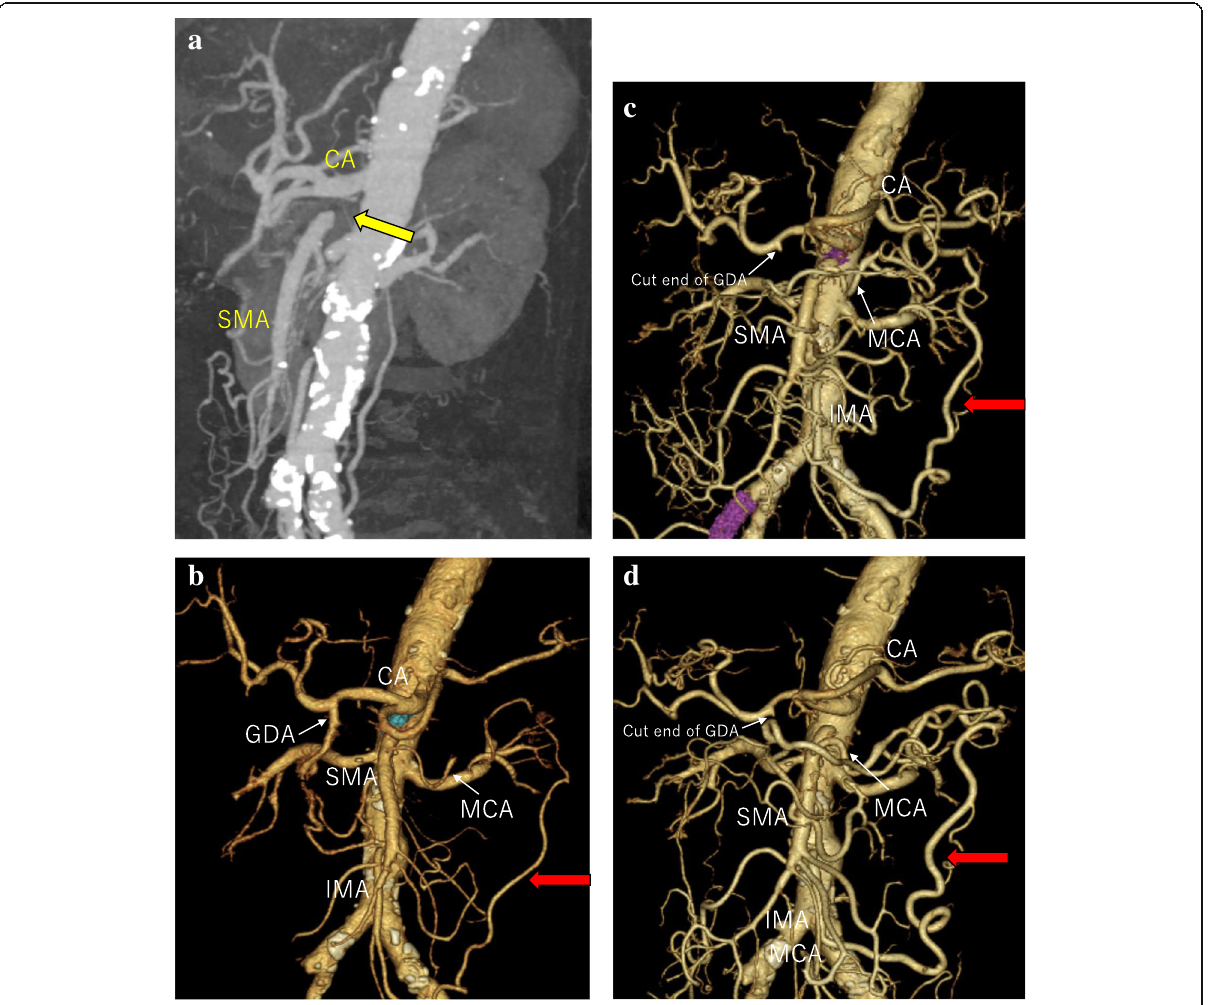
Fig. 3 Superior mesenteric artery occlusion and SMA-IMA anastomosis. a Superior mesenteric artery occlusion was seen before surgery (yellow arrow). b Dilation of SMA and IMA branches before surgery. c Arc of Riolan development observed on postoperative day 98. d Arc of Riolan development observed on postoperative day